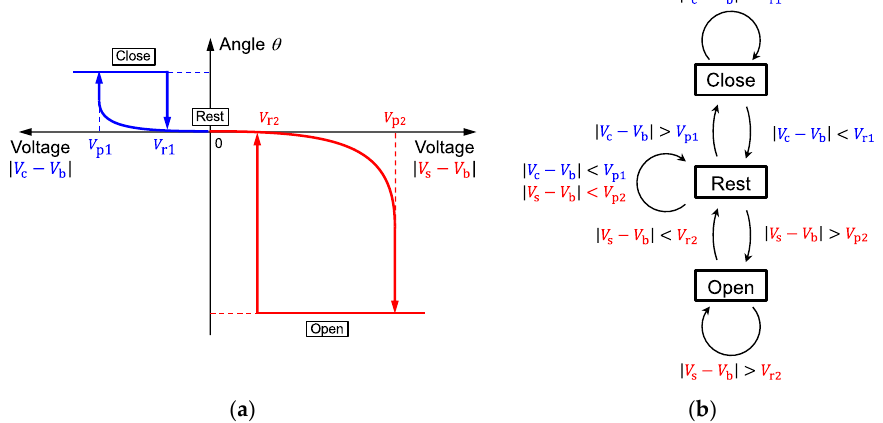
Figure 7. Simplified behavior model of electrostatic shutter operation (close, rest, and open without considering the damped oscillation). ( a ) Unified plot of the shutter angle as a function of applied voltage and ( b ) state transition diagram using the voltage combination as a trigger for transition.